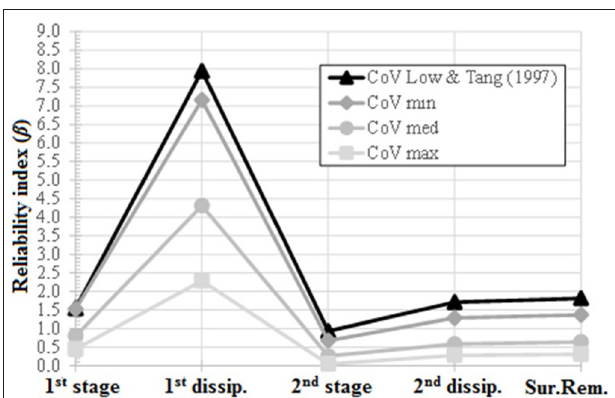
FIGURE 5 | Reliability indexes vs. stages, evaluation of uncertainty level influence (SIGMA/W +